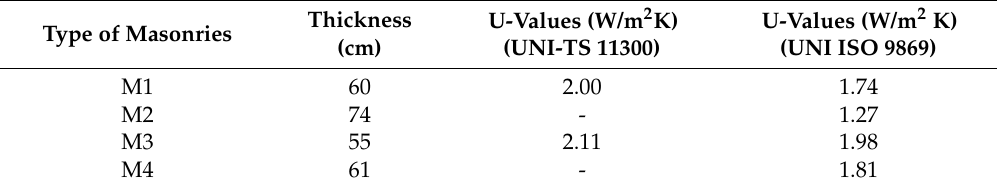
Table 5. Data summary. For each of the four types of masonry the measurement values were reported and compared with the values defined by the current